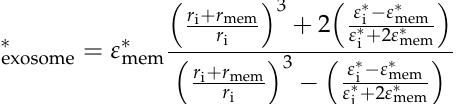
xo1 and f xo2 are the crossover